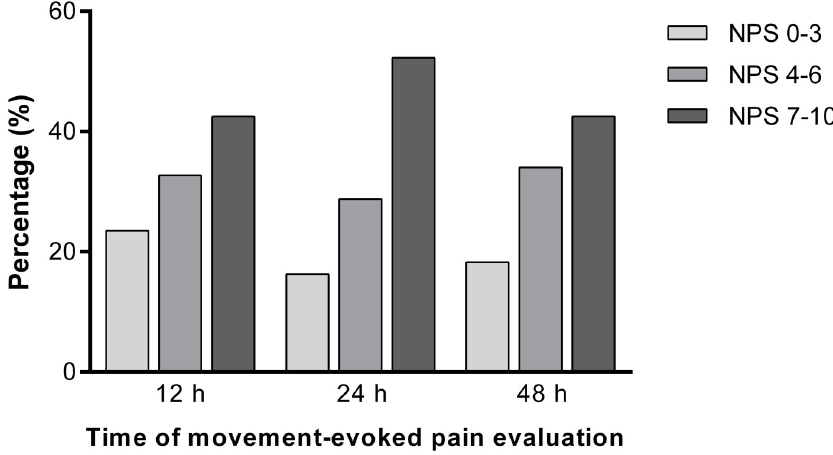
Fig 4. Acute movement-evoked postoperative pain at 12, 24 and 48 hours. NPS 0–3: low pain, NPS 4–6: moderate pain, NPS 7–10: severe pain. NPS, Numeric Pain Scale.